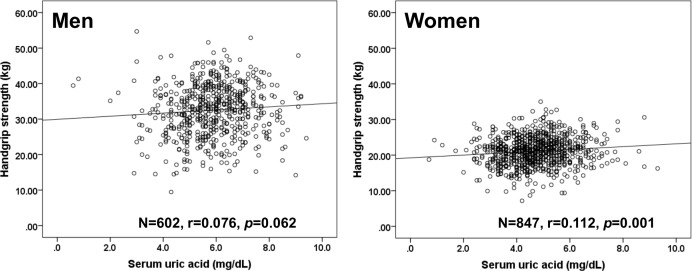
Relationship between serum uric acid (UA) and handgrip strength (HGS) by gender.Solid line, men; dashed line, women. Serum UA levels were significantly correlated with HGS in men (r = 0.138, p<0.001), but not in women (r = 0.071, p = 0.029). There was a significant interaction between gender and increased serum UA on HGS (F = 5.313, p = 0.021).